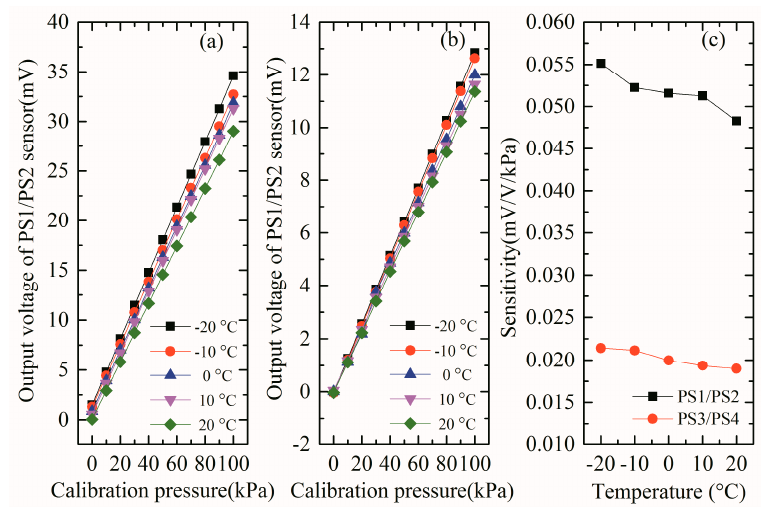
Figure 16. ( a ) The relationship between the output voltages of the PS1/PS2 sensor and the standard pressures; ( b ) the relationship between the output voltages of the PS3/PS4 sensor and the standard pressures, and ( c ) the variety of the sensitivity of array-type pressure sensor with temperature.